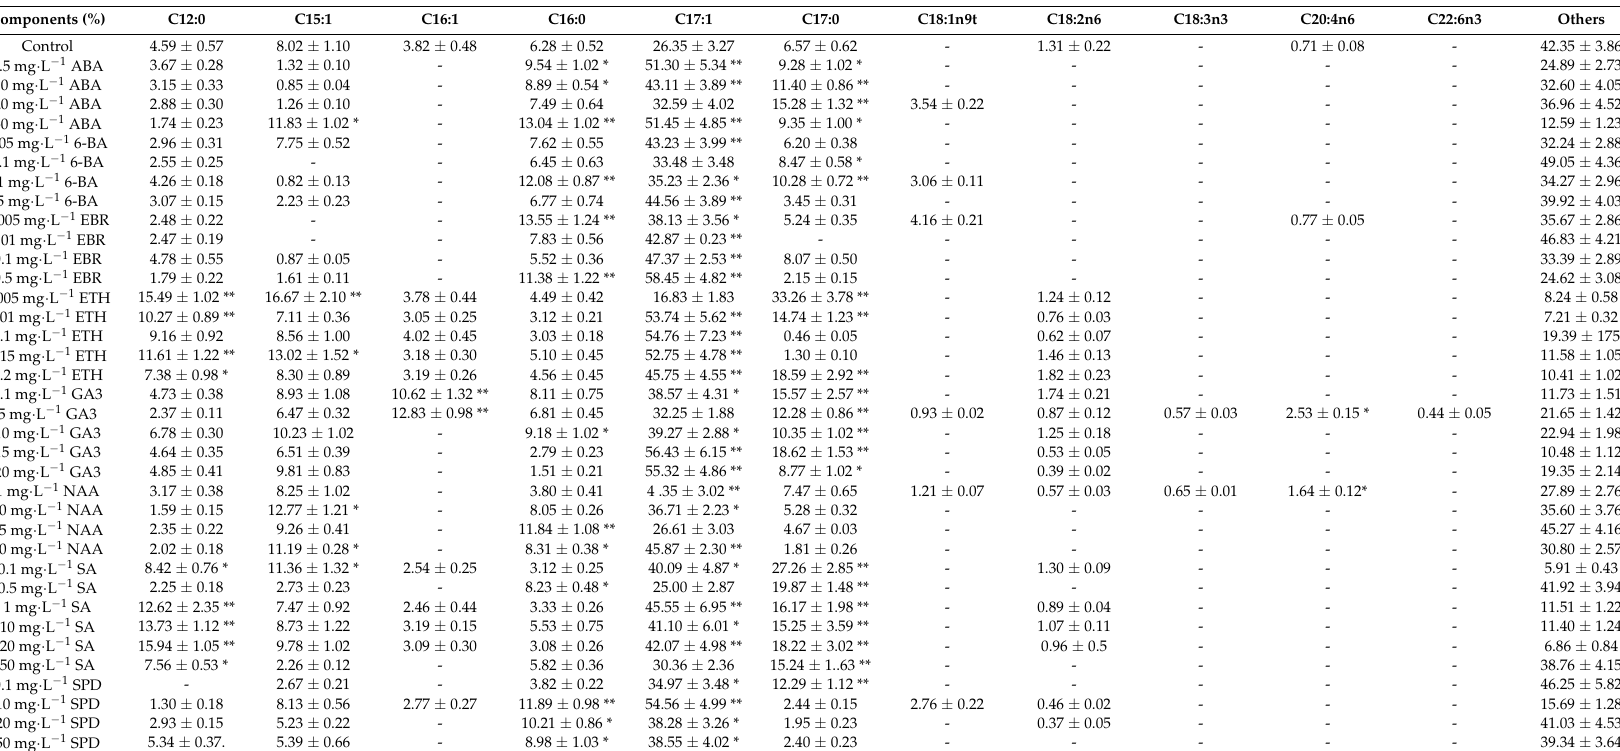
Table 1. Fatty acid profile (%) in control and plant growth regulators; “-” represent this polyunsaturated fatty acid does not exist or is below the instrument detection concentration range. Shown are mean values and SEs from three separately-grown cultures, each. “*” represented increased significantly ( p < 0.05) and “**” increased different significantly ( p < 0.01),